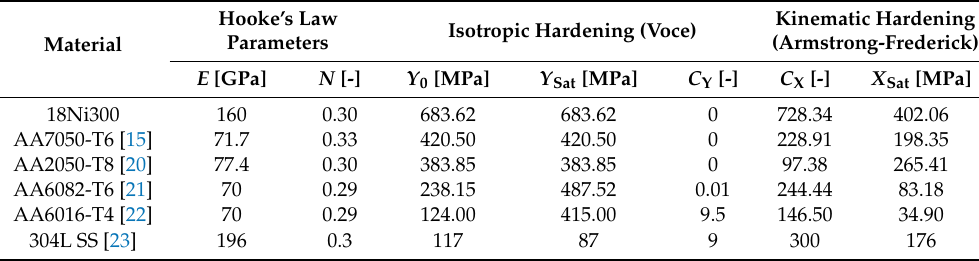
Table 3. Elastic-plastic parameters (AA—Aluminum Alloy; SS—Stainless Steel).